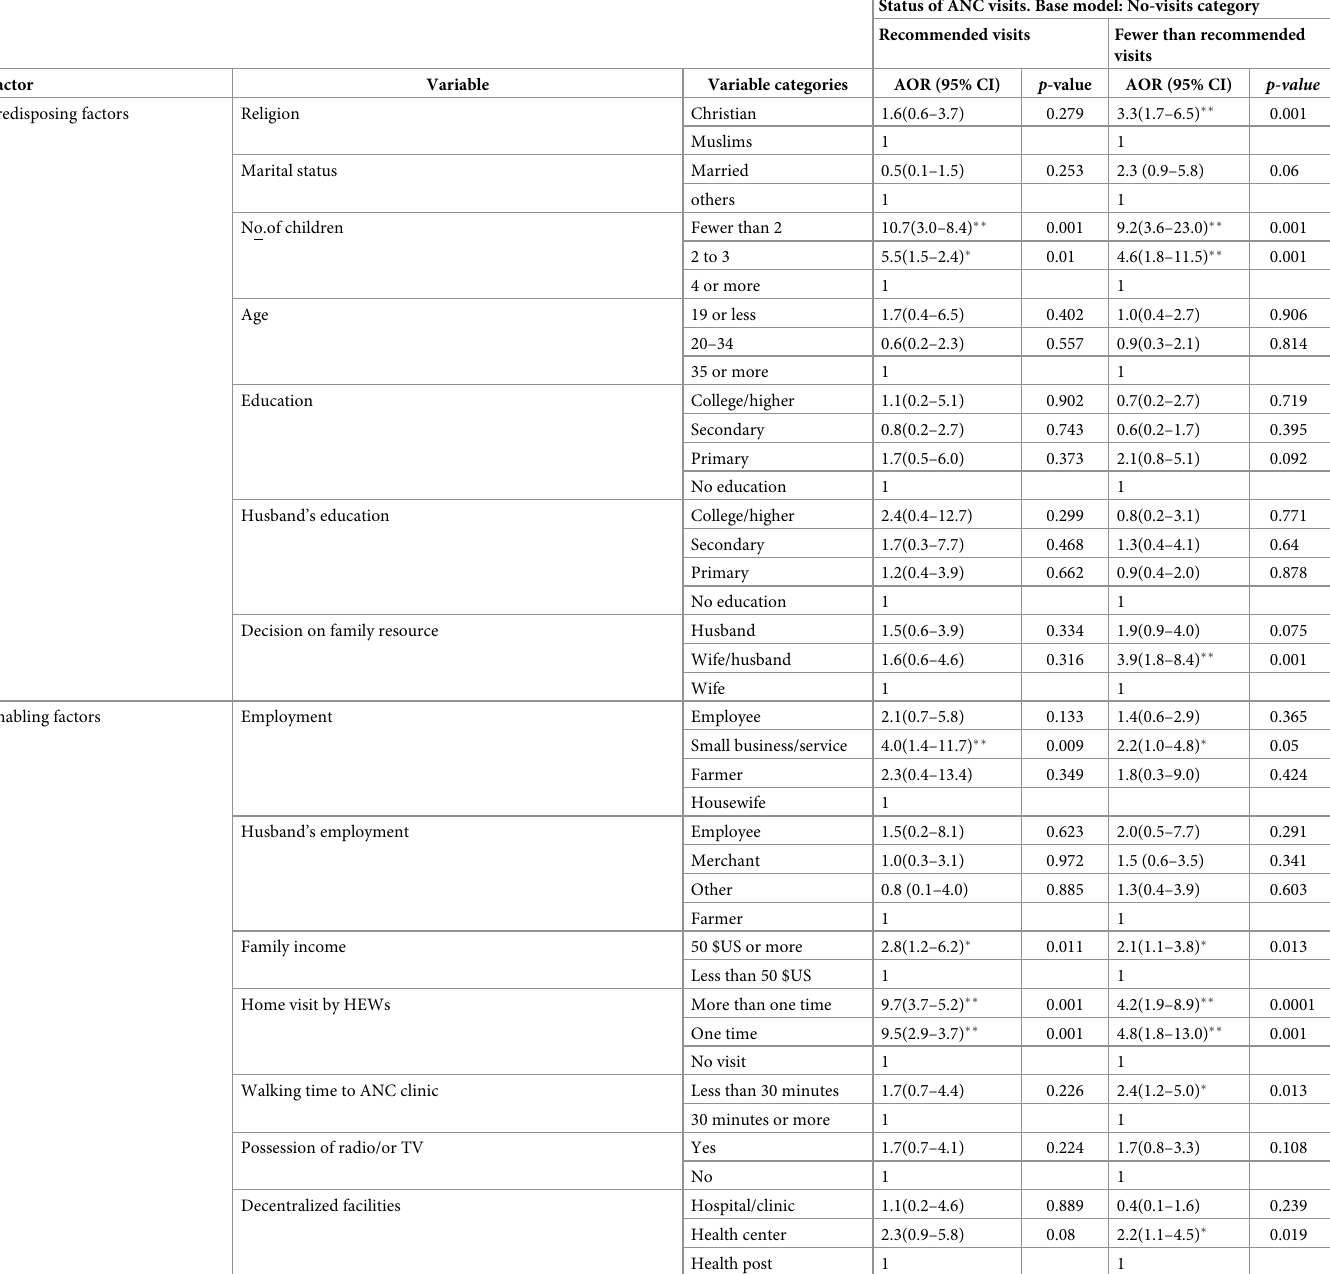
Status of ANC visits. Base model: No-visits